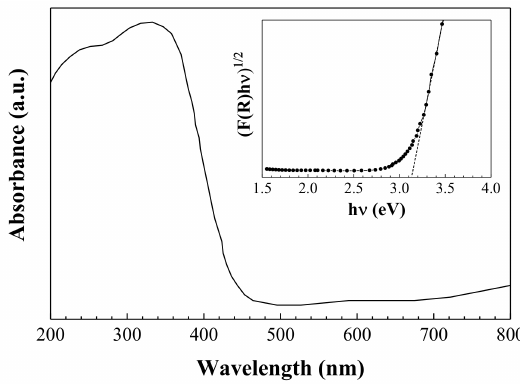
Figure 7. Diffuse reflectance spectrum and band gap energy (inset) of α -MoO 3